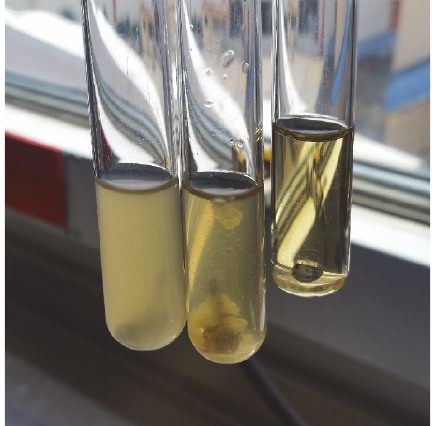
Figure 1: Growth in trypticase soy broth